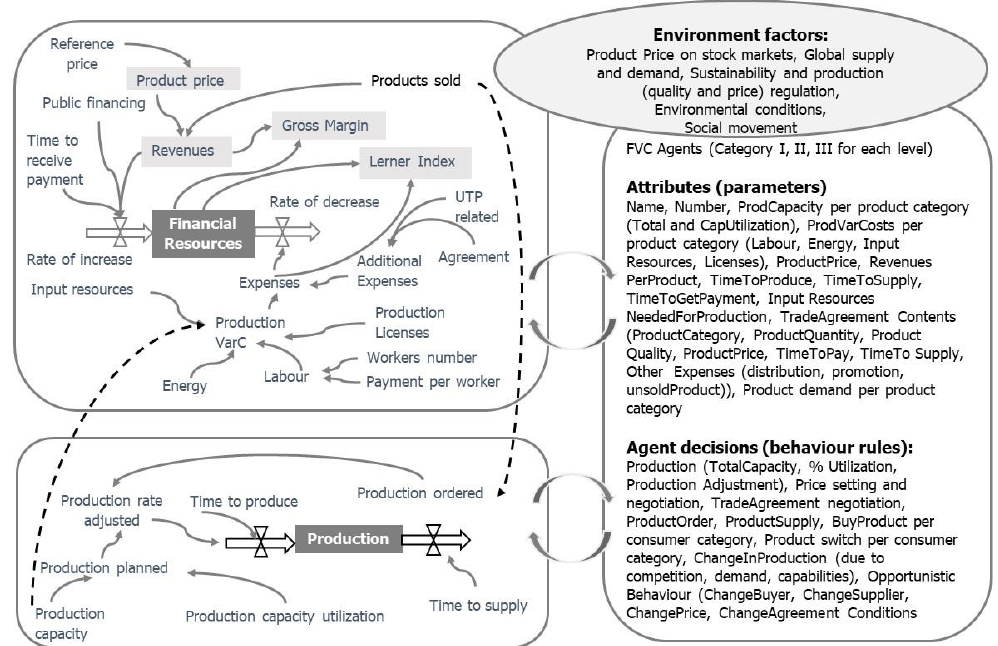
Figure 7. A hybrid of SD and ABM simulation modelling conceptualisation for a generic FVC (Authors’ own conceptualisation adapted from VALUMICS project’s deliverable [67]). System dynamics flows of products and finance are on the left, and agent attributes and decisions on the right.